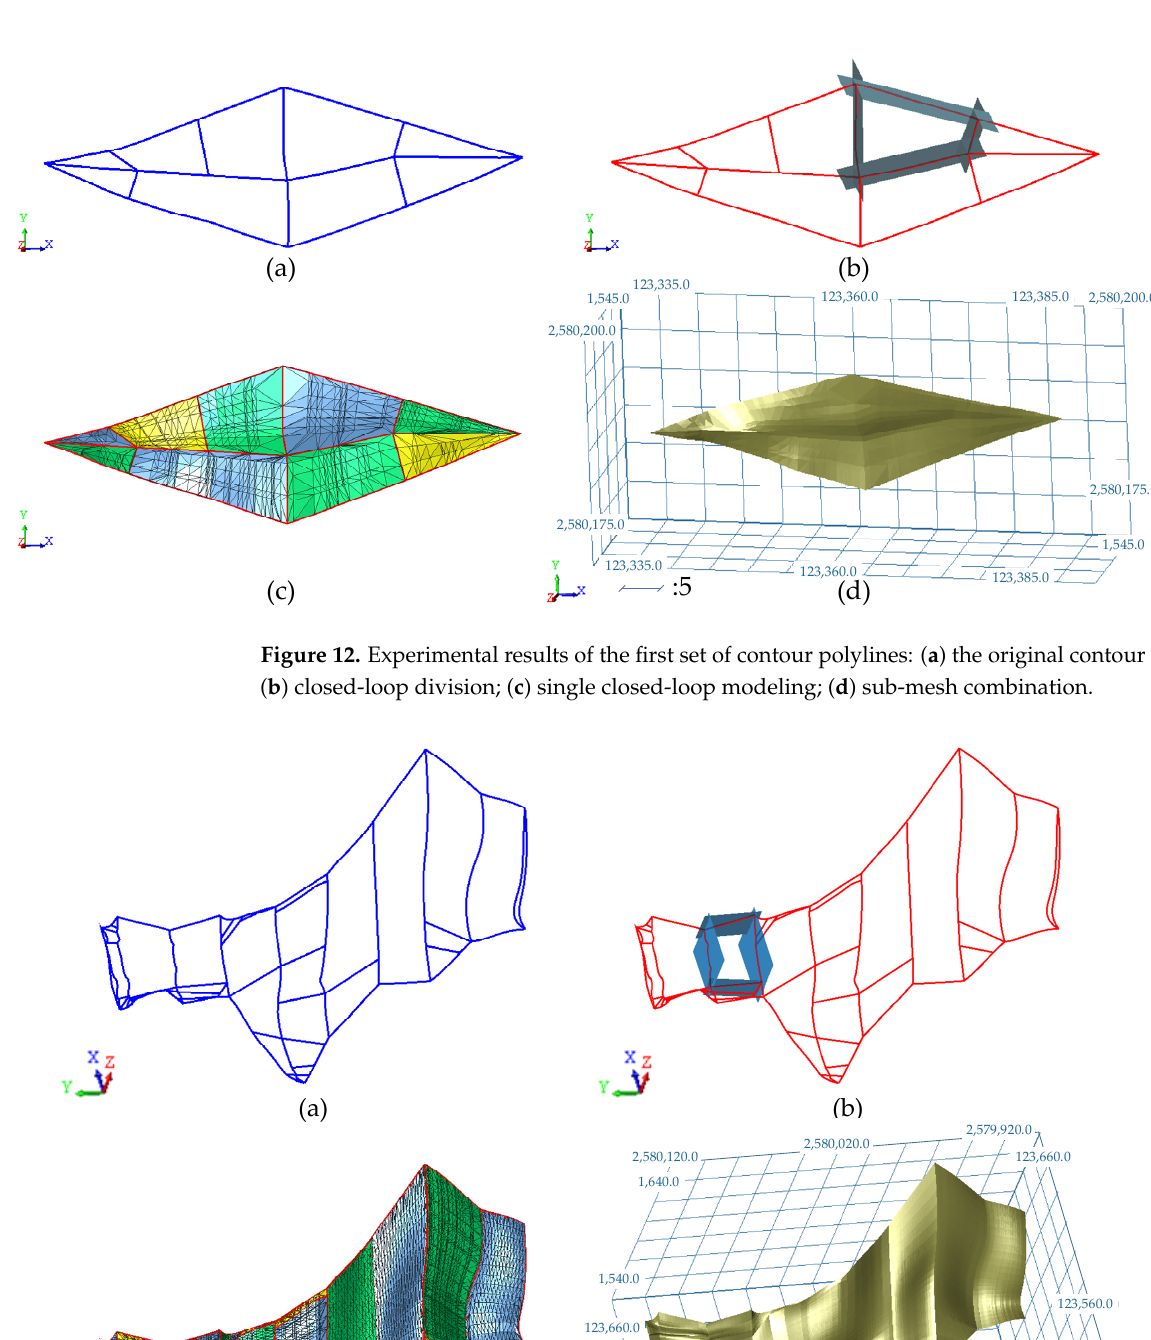
Figure 13. Experimental results of the second set of contour polylines: ( a ) the original contour polylines; ( b ) closed-loop division; ( c ) single closed-loop modeling; ( d ) sub-mesh combination.